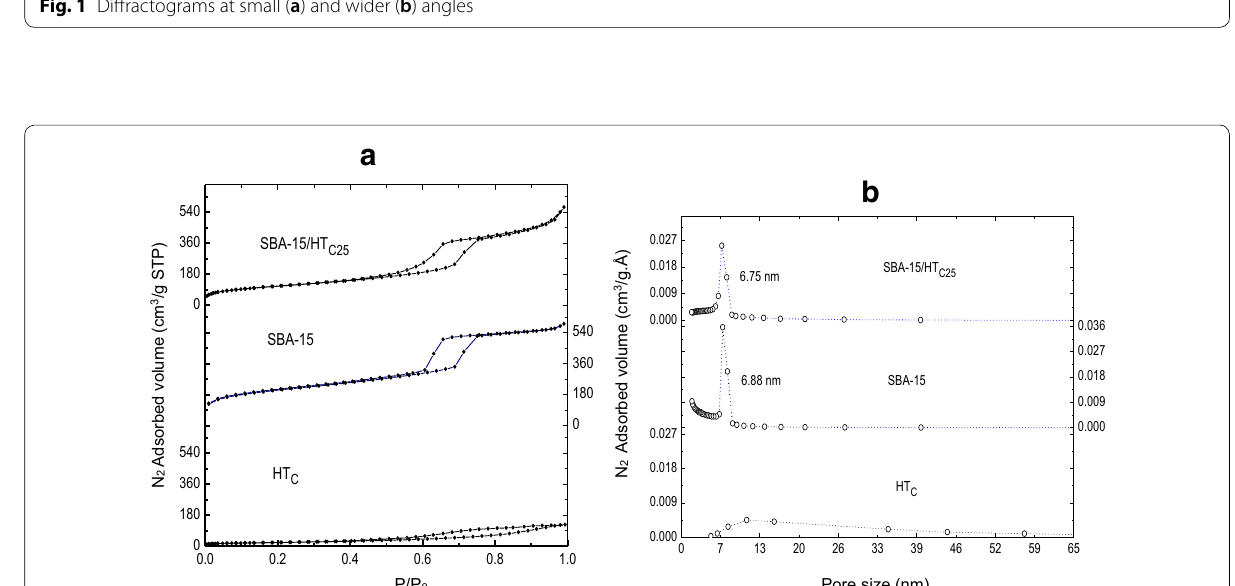
Fig. 2 N 2 adsorption isotherms ( a ) and pore size distribution ( b ) of the HT C , SBA‑15, and SBA‑15/HT